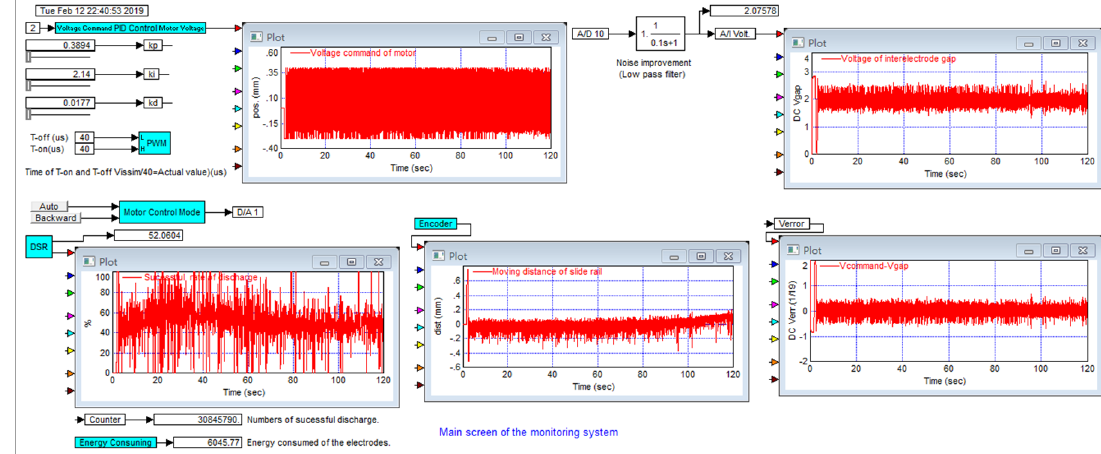
Figure 4. Main screen of the real-time monitoring and control (RTMAC) system.